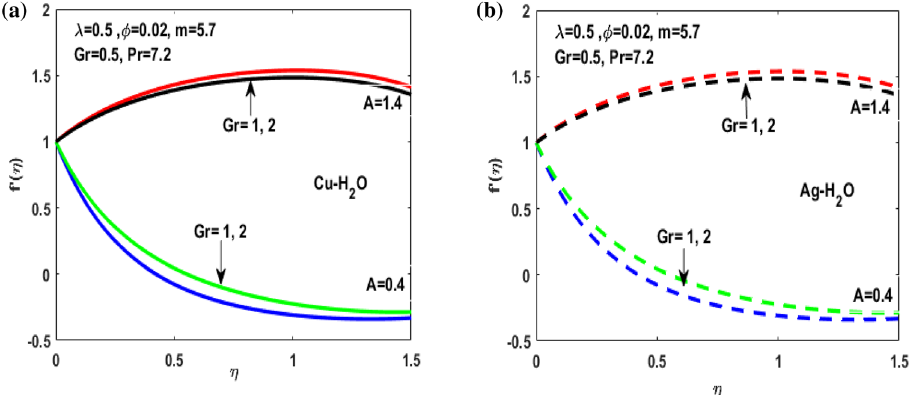
Figure 6. ( a ) Impact of Gr on f ′ (η) . ( b ) Impact of Gr on f ′ (η) .